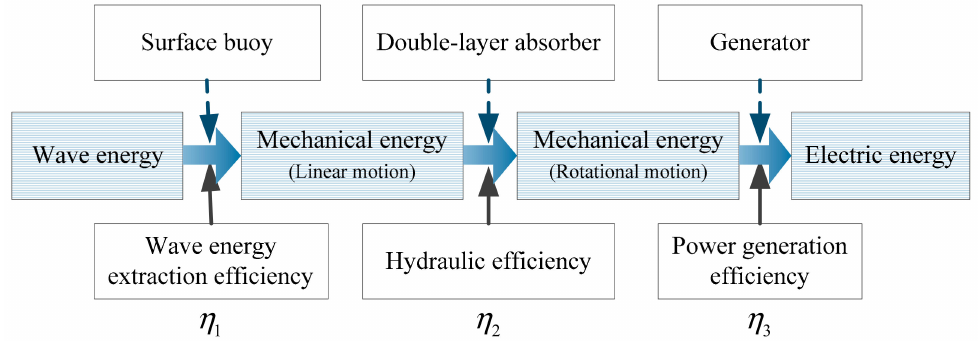
Figure 9. Energy conversion flow